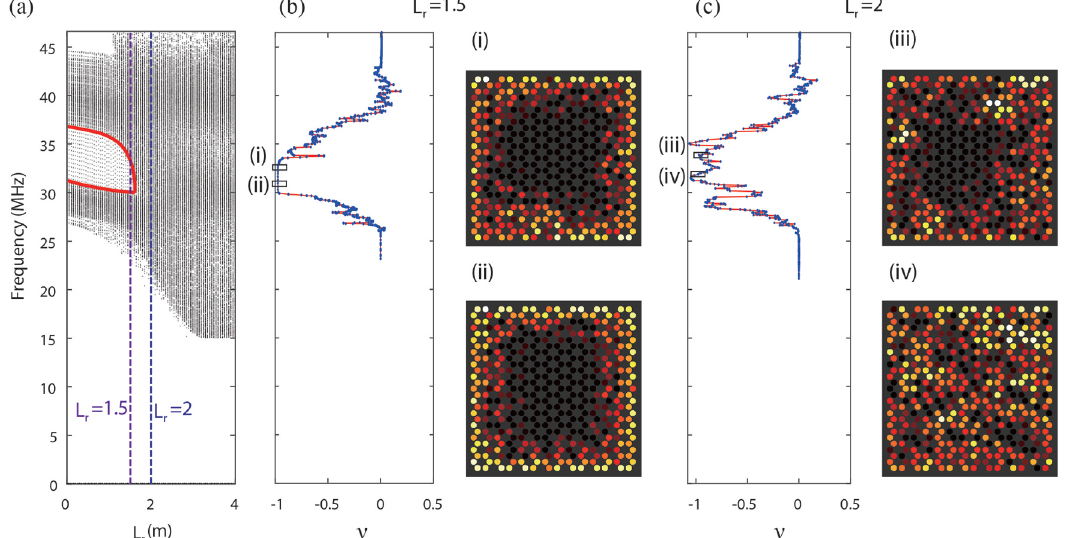
Fig. 3. (a) Energy spectrum vs. L r for a 13 (cid:4) 13 sample. (b) The left panel is the computed local Chern numbers as a function of frequency for L r =1.5. The right panel shows two edge states with the frequencies marked in the left panel. (c) The left panel is the local Chern numbers for a bigger disorder of L r = 2. The right panel shows a bulk state and an edge state,